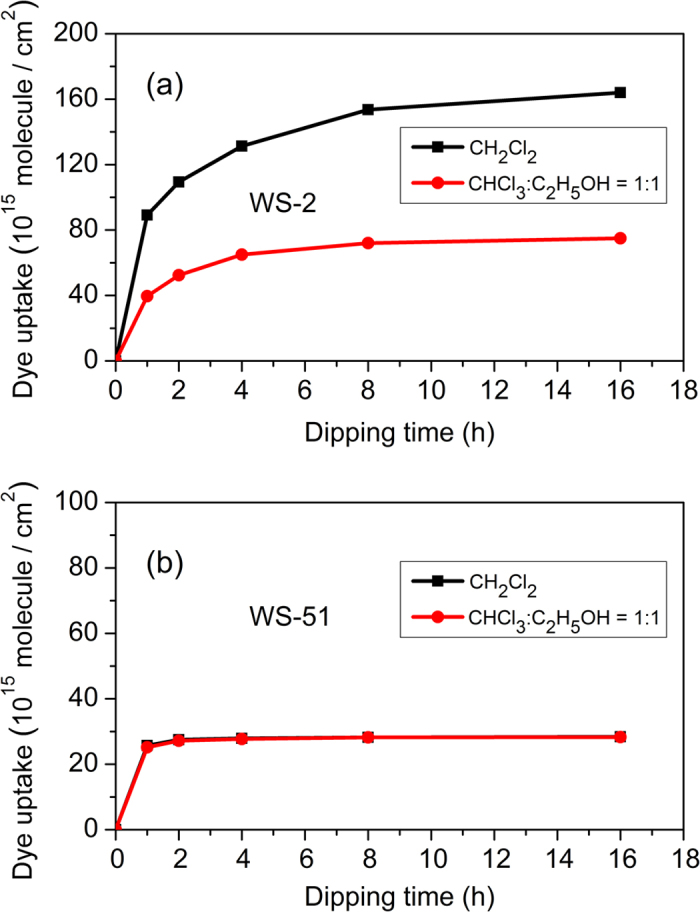
Absorption profiles of WS-2 (a) and WS-51 (b)on TiO2 photoanodes under different dye bath system.